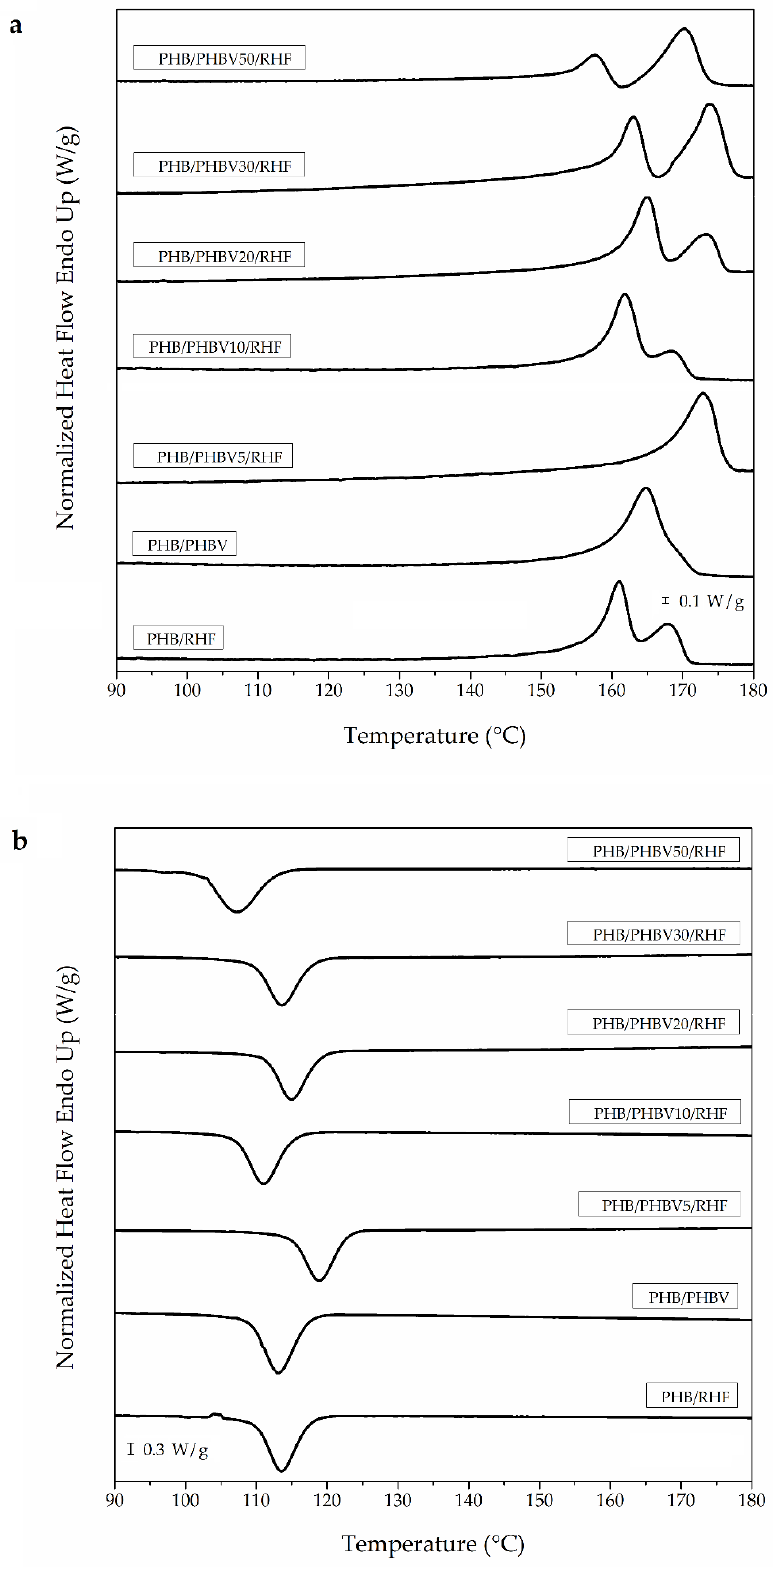
Figure 5. Di ff erential scanning calorimetry (DSC) curves during ( a ) heating and ( b ) cooling of the thermo-compressed films made of poly(3-hydroxybutyrate) (PHB), poly(3-hydroxybutyrate- co -3-hydroxyvalerate) (PHBV), and rice husk flour (RHF).